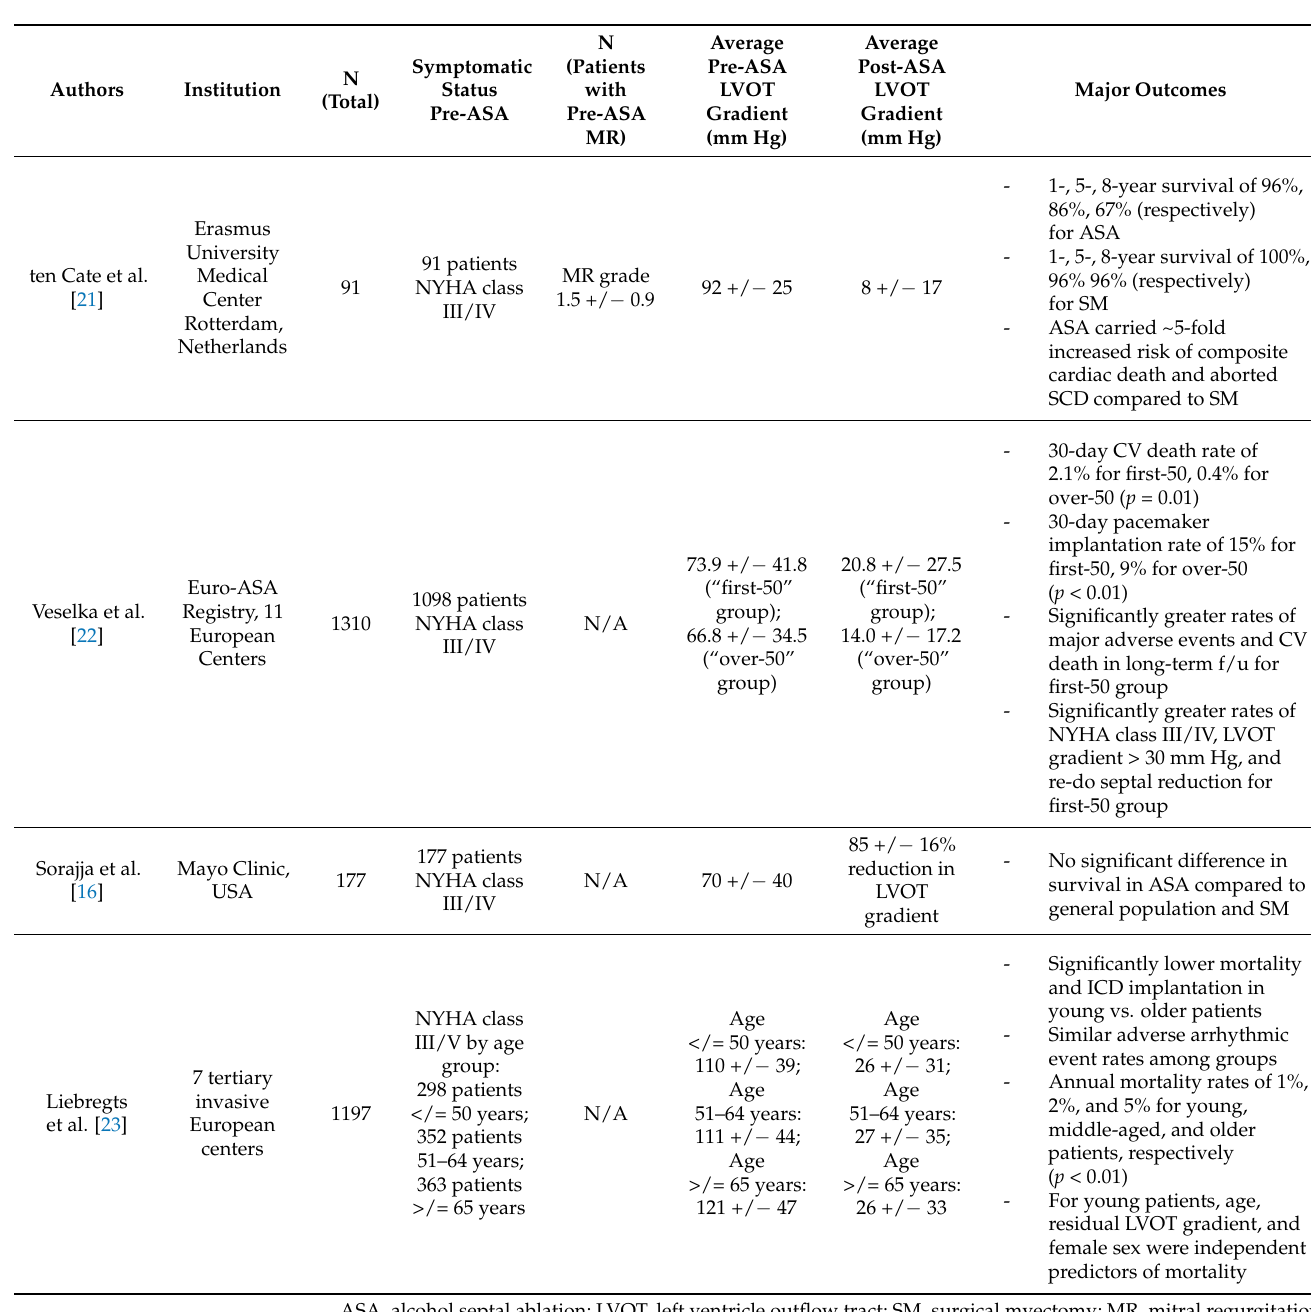
Surgical septal myectomy is considered the gold-standard treatment for HOCM [4]. Figure